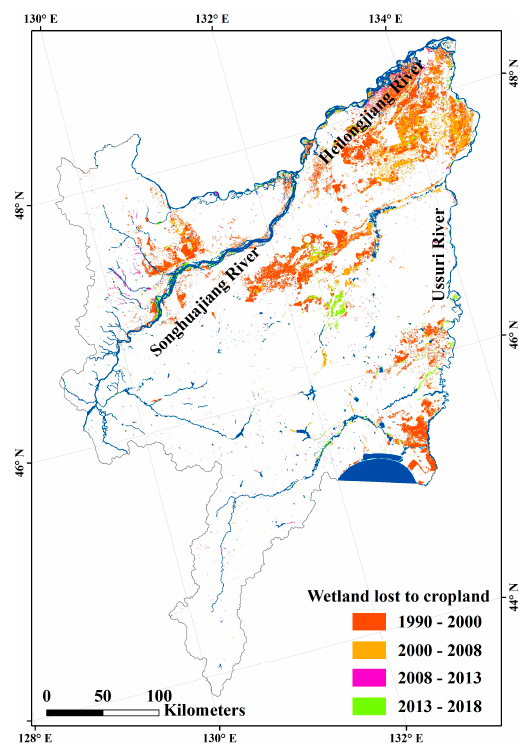
Figure 4. Distribution of wetlands lost to croplands in the SJP during different periods. Table 2. Losses of wetlands to croplands in the SJP during different time periods.